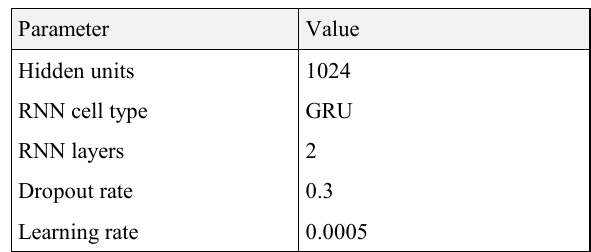
Figure 7: NO 2 prediction, station DDCS (L1-Loss: 5.22)